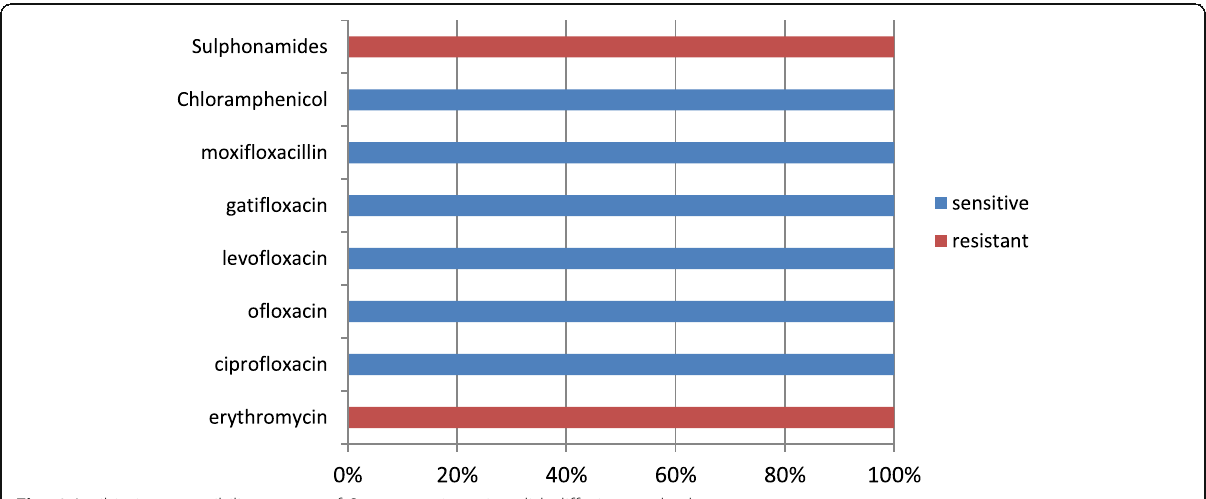
Fig. 6 Antibiotic susceptibility pattern of S. pneumoniae using disk diffusion method